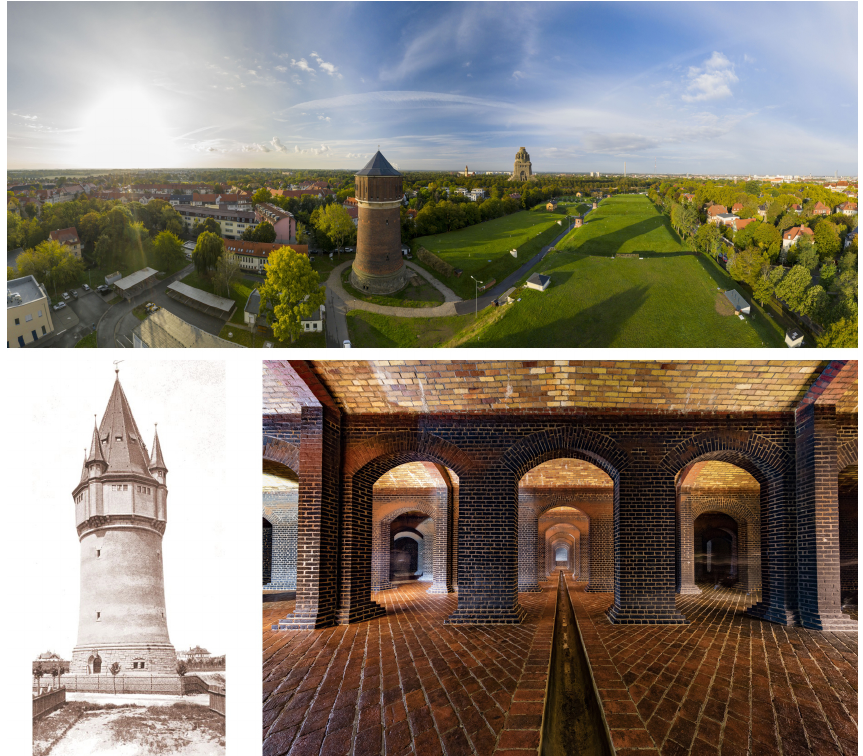
Figure 13. The Probstheida waterworks, Leipzig, planned and designed by Adolf Thiem. The picture at the top shows an aerial view, with the water tower (foreground left) and water storage cellars with grass cover. The tower of the Völkerschlacht monument is visible in the background, and the small tower to its left is part of the chapel of the Südfriedhof where the Thiem family grave is located. The bottom left image is of the water tower in its original shape, around 1907. The roof was damaged in World War II and rebuilt in a simplified form. The lower right image shows the inside of water storage cellar (photos: Leipziger Gruppe, with